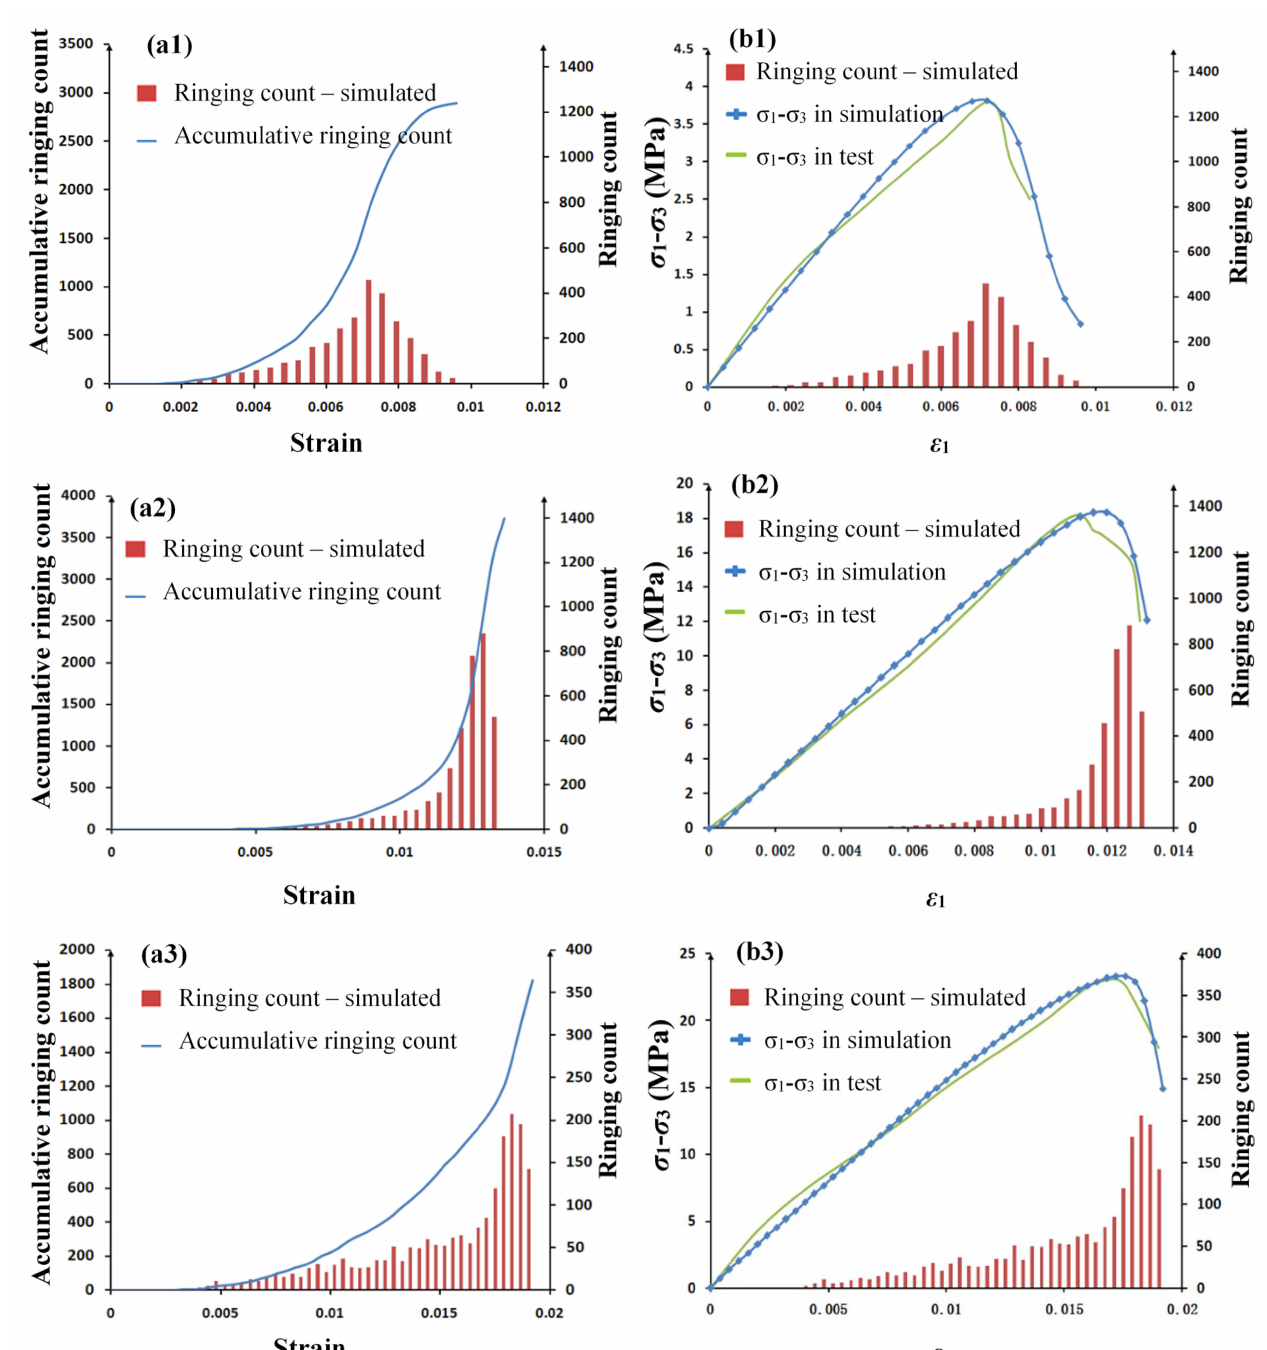
Figure 11. Damage characteristics of red-bed soft rock under the water-stress coupled triaxial compression numerical test (confining pressure in ( a1 , b1 ) is 0, in ( a2 , b2 ) is 1 MPa, in ( a3 , b3 ) is 3